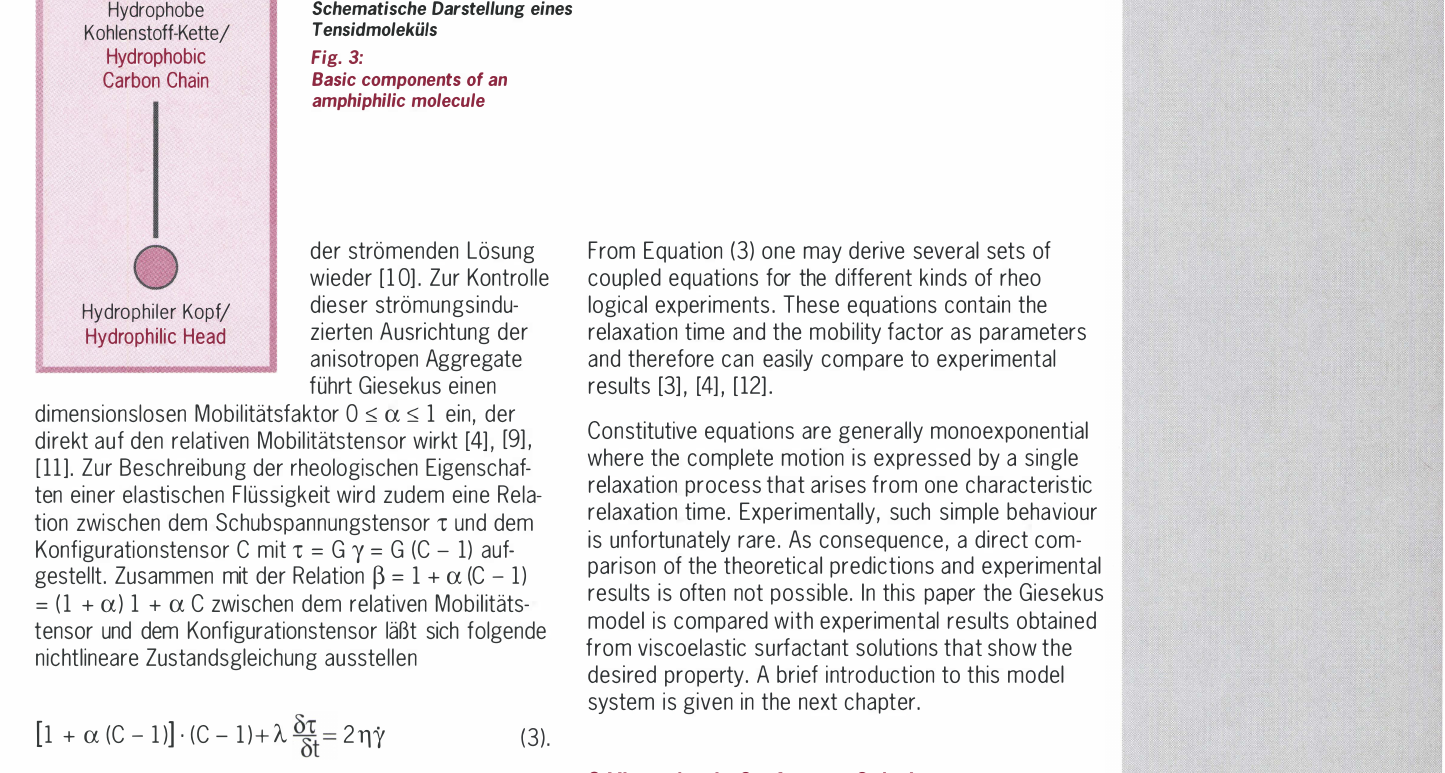
Fig. 3: Basic components of an